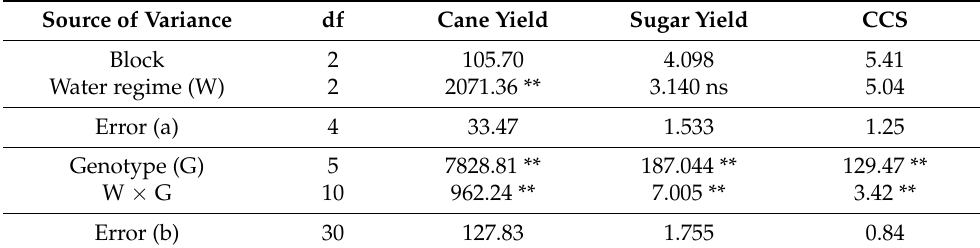
Table 12. Mean squares for sugar yield, cane yield and commercial cane sugar (CCS) of six sugarcane genotypes under early drought conditions.